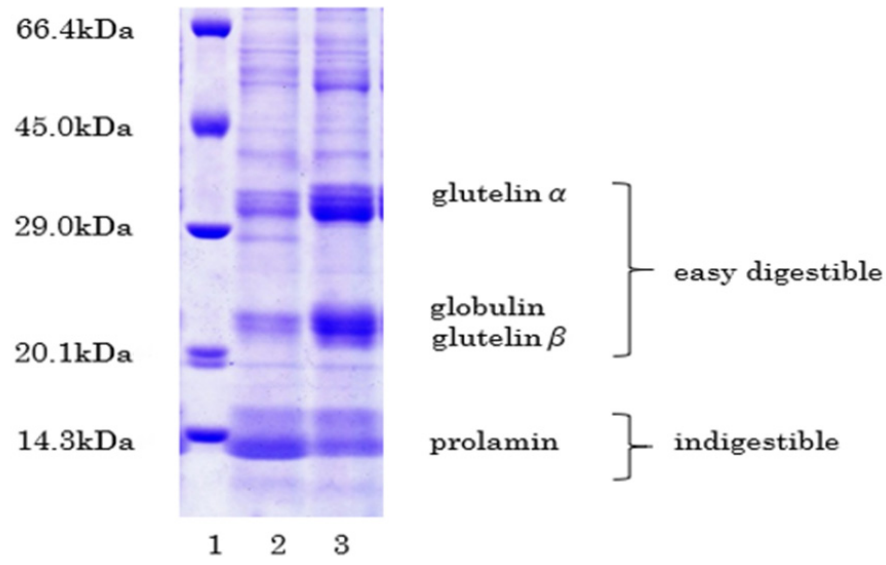
Figure 3. Western blot of Himeiku-83. 1: molecular maker; 2: Himeiku-83; 3: Hinohikari.